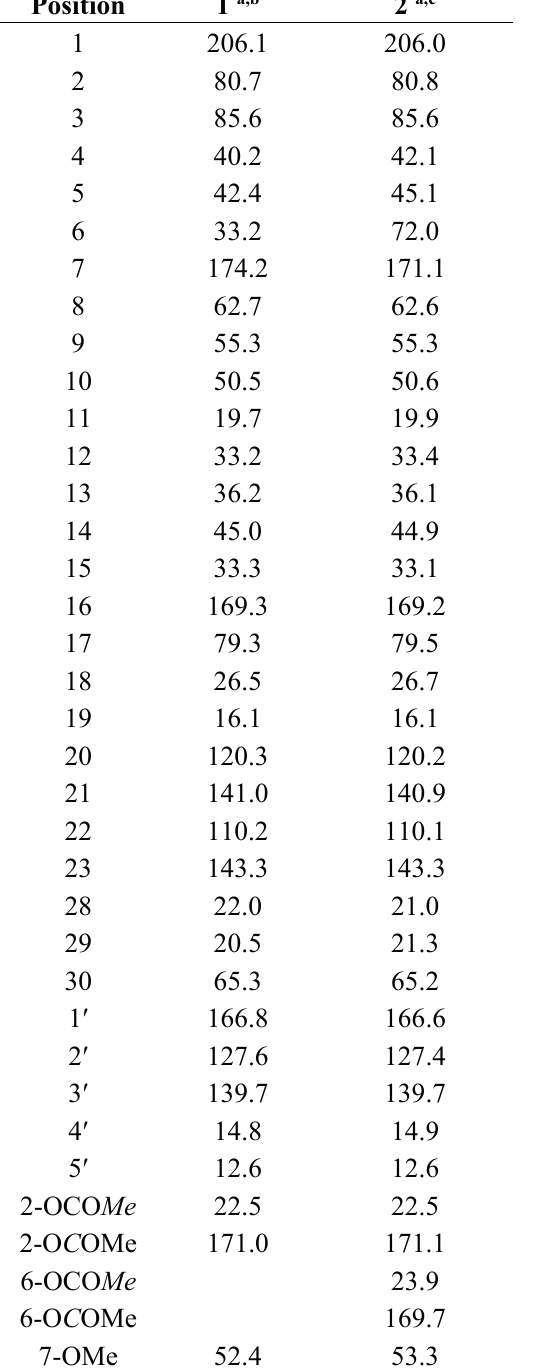
Table 2. 13 C-NMR data of 1 and 2